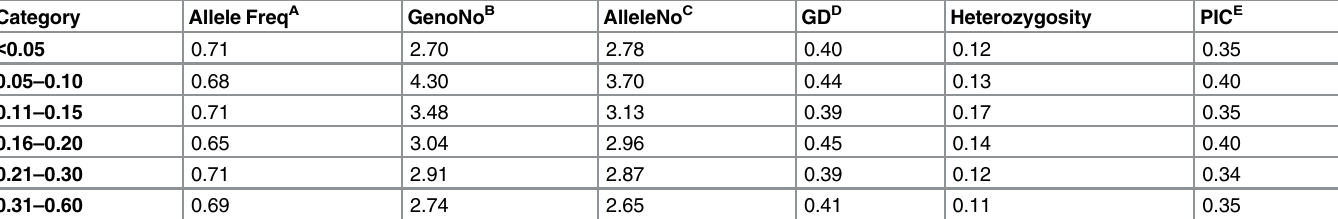
Table 4. Genetic diversity of pepper fruit pericarp thickness. Category Allele Freq A GenoNo